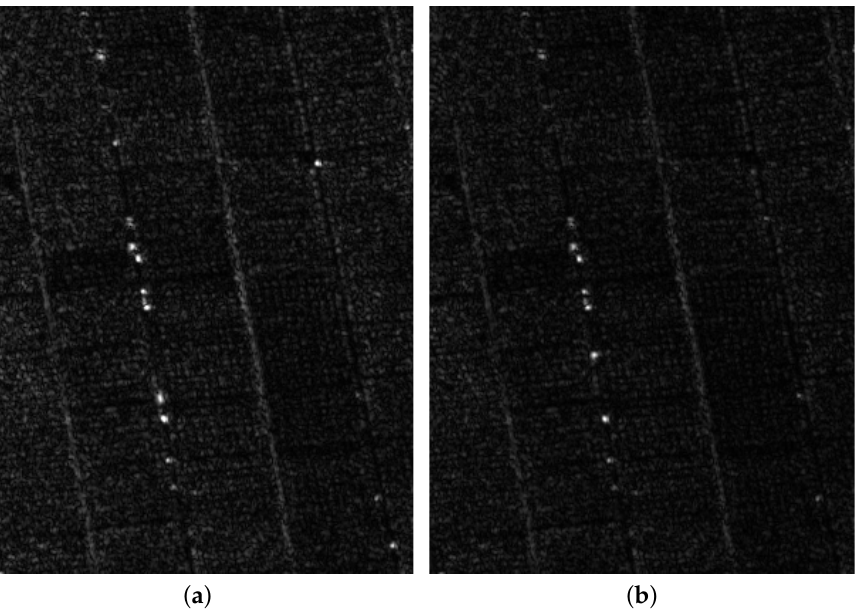
Figure 6. The P-band SAR images of the experimental scene. ( a ) Reference SAR image. ( b ) Mission SAR image.